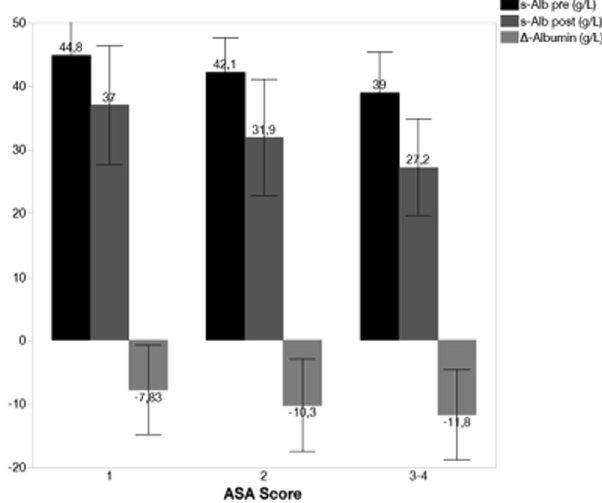
Figure 3. Serum albumin concentrations (pre-, post- and drop) in different ASA